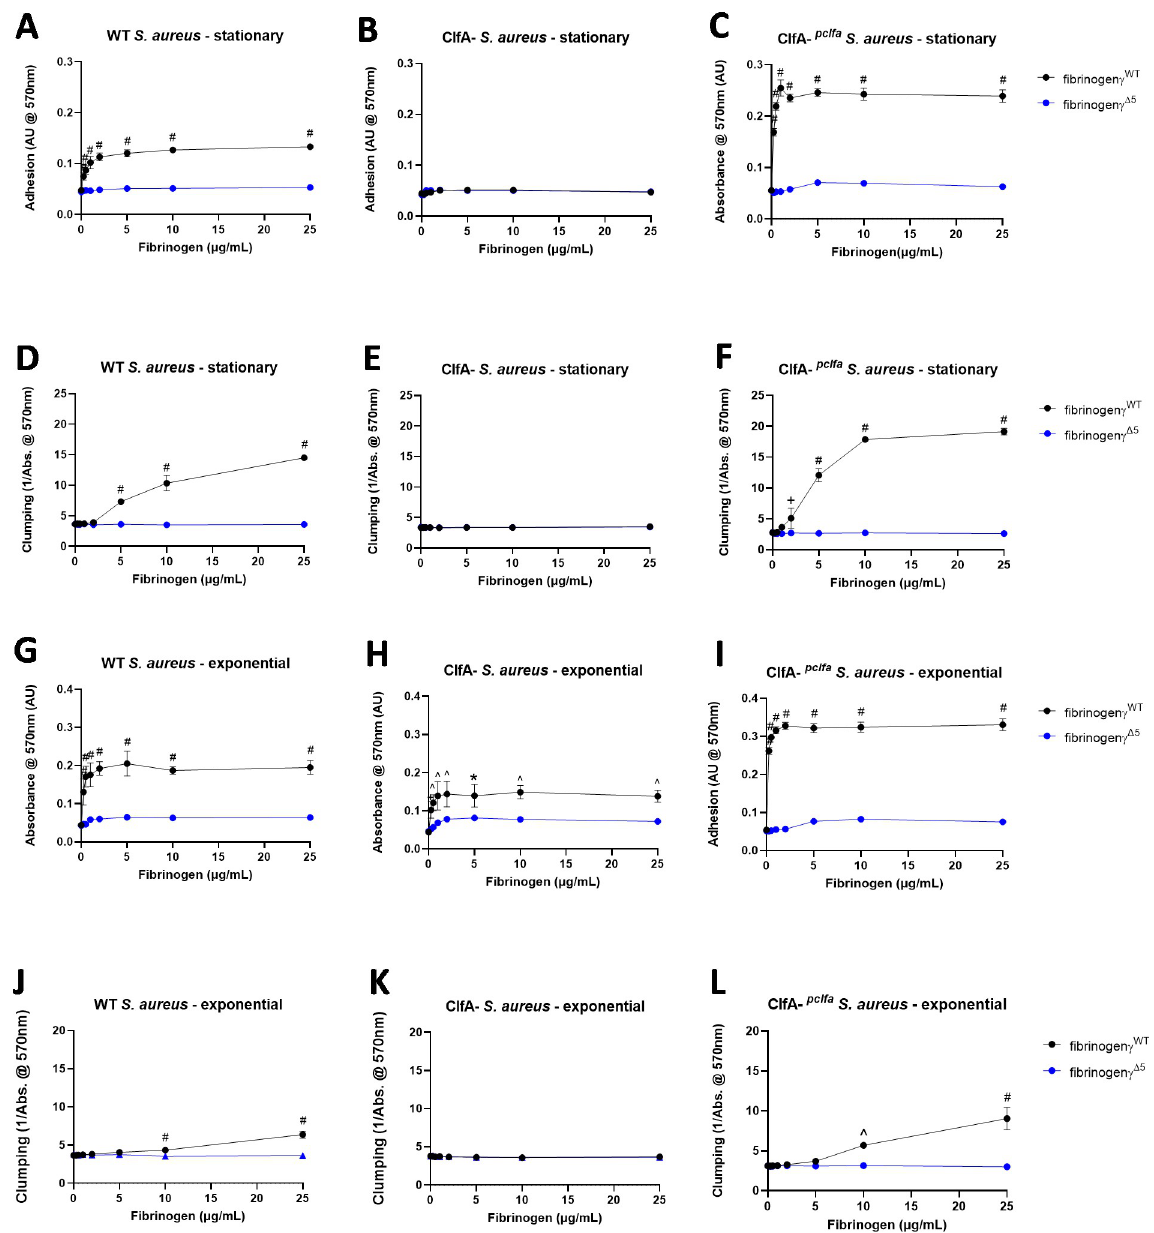
Fig 1. The fibrin(ogen) AGDV binding motif is required for both S. aureus adhesion to immobilized fibrinogen and clumping in fibrinogen solution. Adhesion of stationary phase (A) WT S . aureus USA300, (B) ClfA- S . aureus USA300, and (C) ClfA- pclfa S . aureus USA300 to immobilized fibrinogen γ WT or fibrinogen γ Δ 5 . Clumping of stationary phase (D) WT S . aureus USA300, (E) ClfA- S . aureus USA300, or (F) ClfA- pclfa S . aureus USA300 in solutions containing fibrinogen γ WT or fibrinogen γ Δ 5 . Adhesion of exponential phase (G) WT S . aureus USA300, (H) to ClfA- S . aureus USA300, or (I) ClfA- pclfa S . aureus USA300 to immobilized fibrinogen γ WT or fibrinogen γ Δ 5 . Clumping of exponential phase (J) WT S . aureus USA300, (K) ClfA- S . aureus USA300, or (L) ClfA- pclfa S . aureus USA300 in solutions containing fibrinogen γ WT or fibrinogen γ Δ 5 . Data is derived from N = 3 replicates per fibrinogen concentration per group and presented as mean absorbance (for adhesion experiments) or the inverse of mean absorbance (for clumping experiments) ± SEM. Statistical significance was determined by 2- way ANOVA with Sˇı´da´k’s multiple comparisons test where + = < 0.05, � = < 0.01, ^ = < 0.001, and # = < 0.0001.